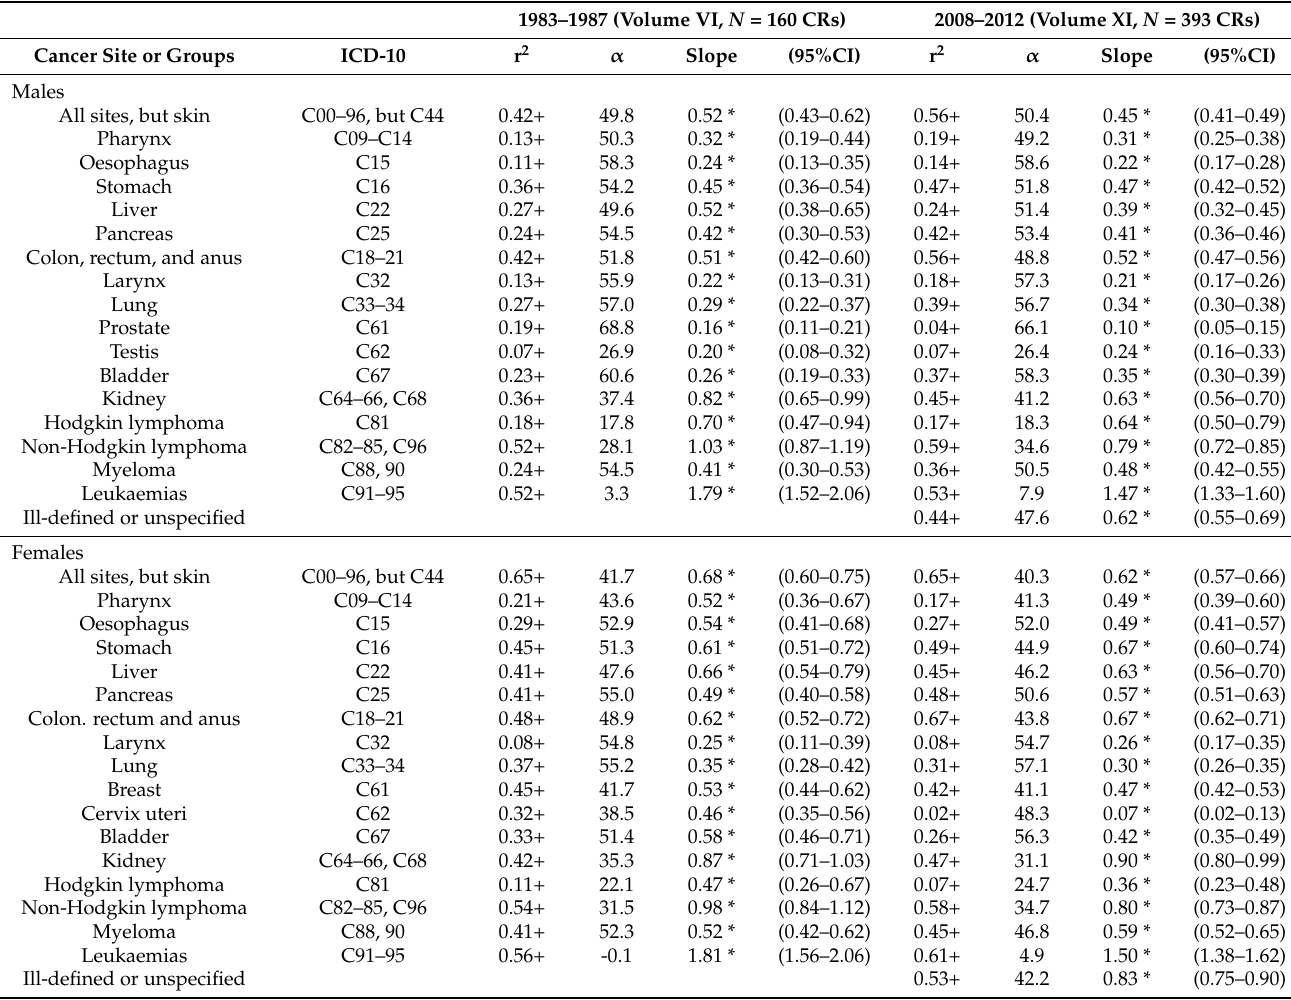
Table 1. Linear regression between median age of the population as a predictor of the median age of the studied cancers according to two periods (1983–1987 and 2008–2012) recorded by the Cancer in Five Continents volumes (VI and XI, respectively) and